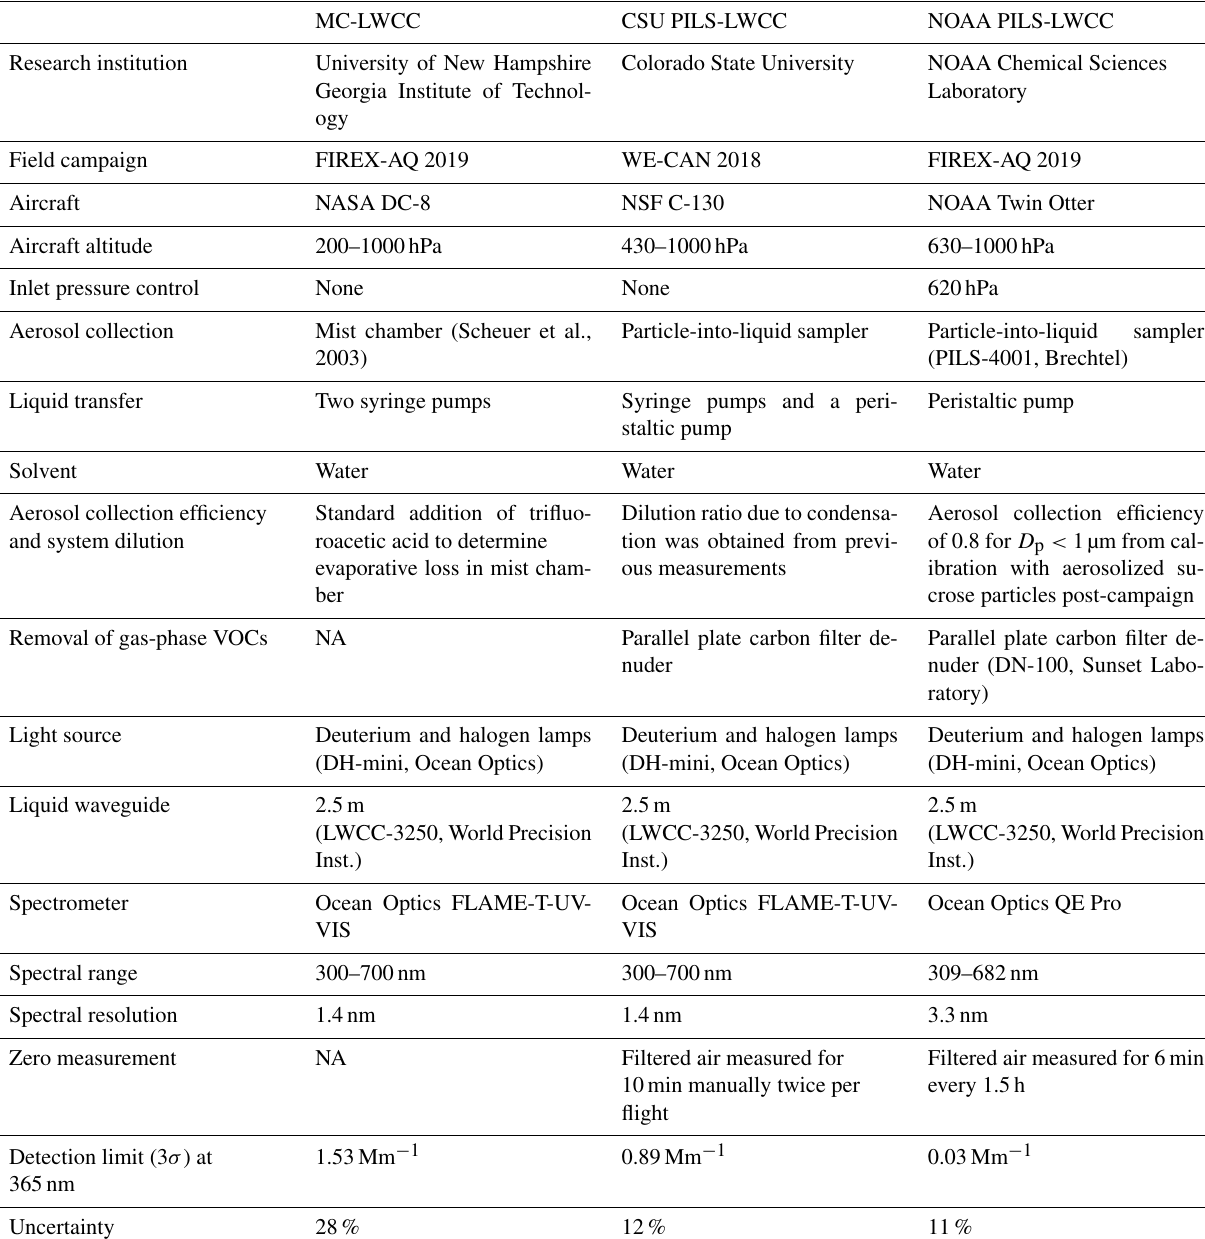
Table 1. Overview of BrC instruments deployed during WE-CAN 2018 and FIREX-AQ